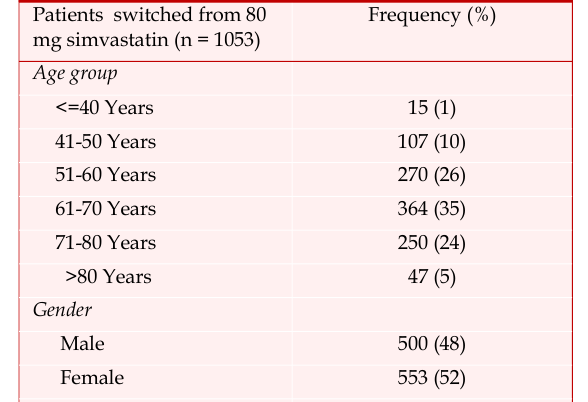
Proportion of female and male patients and their age group in Scotland those were prescribed simvastatin from 01/03/2005 to 28/02/2010